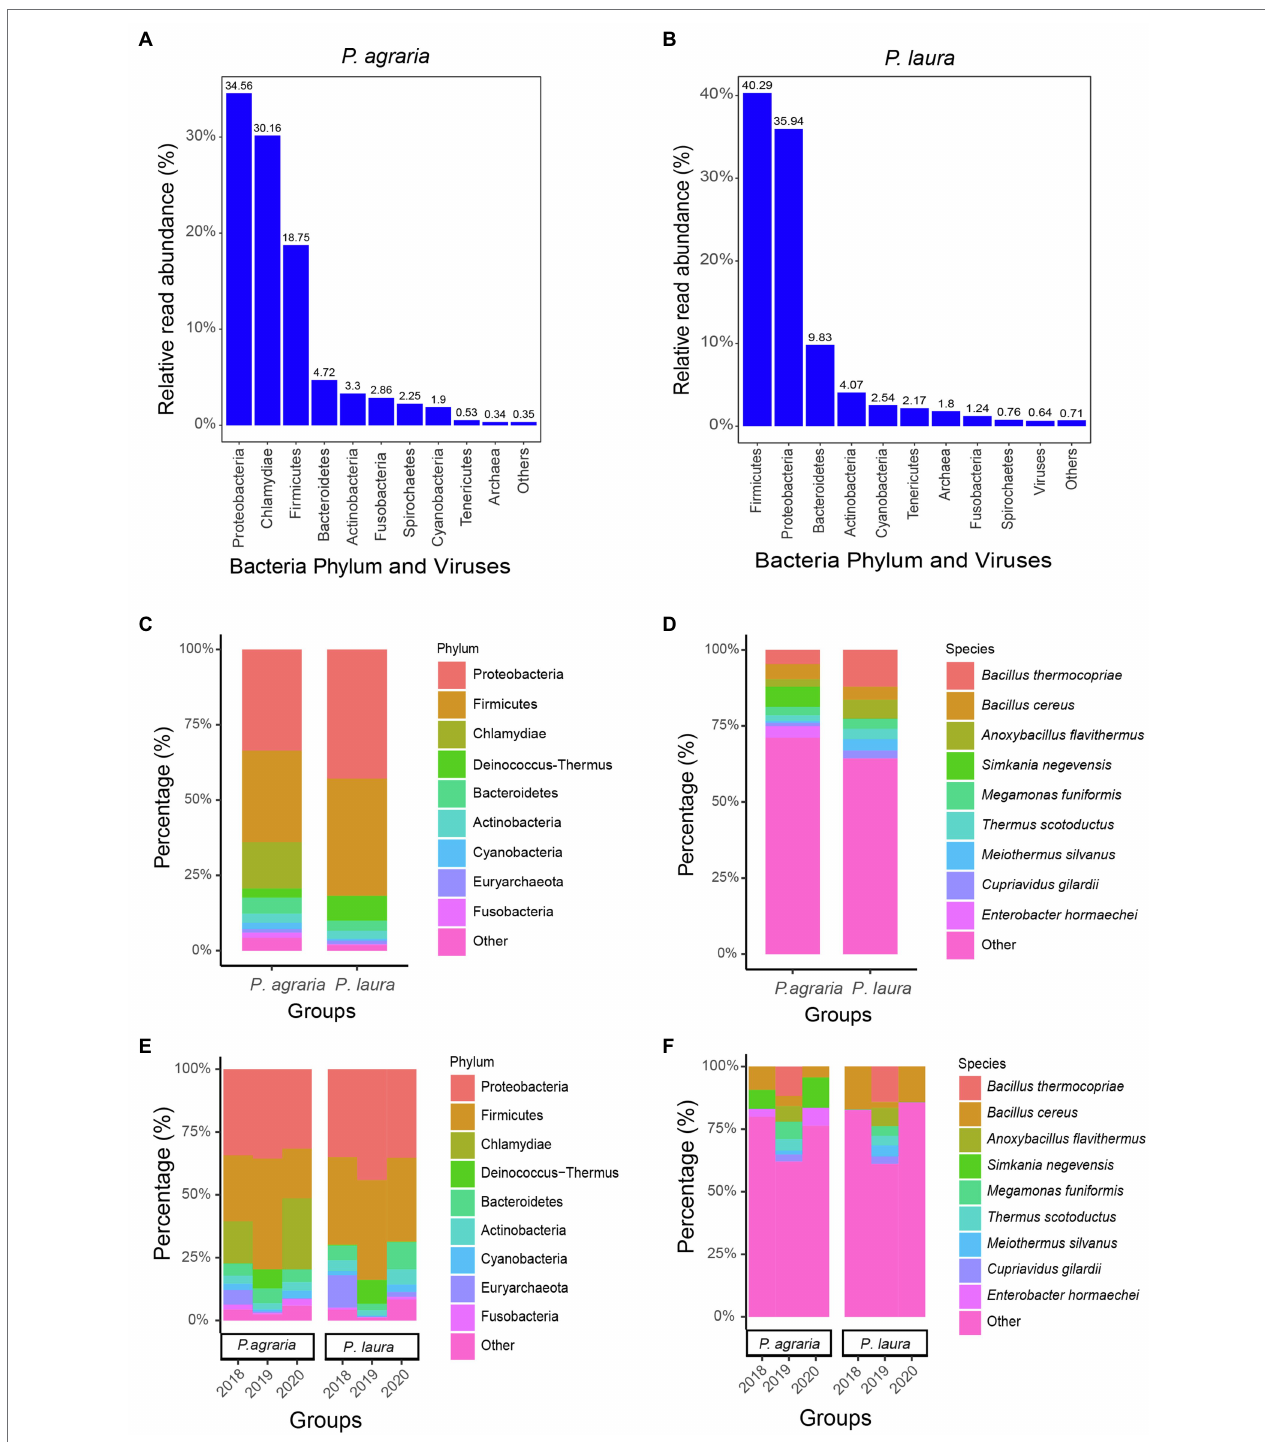
FIGURE 2 | Gut microbiome composition of the two Pardosa species. The relative read abundance comparisons by bacteria phylum and viruses for Pardosa agraria (A) and Pardosa laura (B) . Relative percentages (for the period 2018–2020) for microbiome at the phylum (C) and species (D) levels based on mixed sequencing of the gut contents of 20 spiders, and their relative percentages for each year at the phylum (E) and species (F)